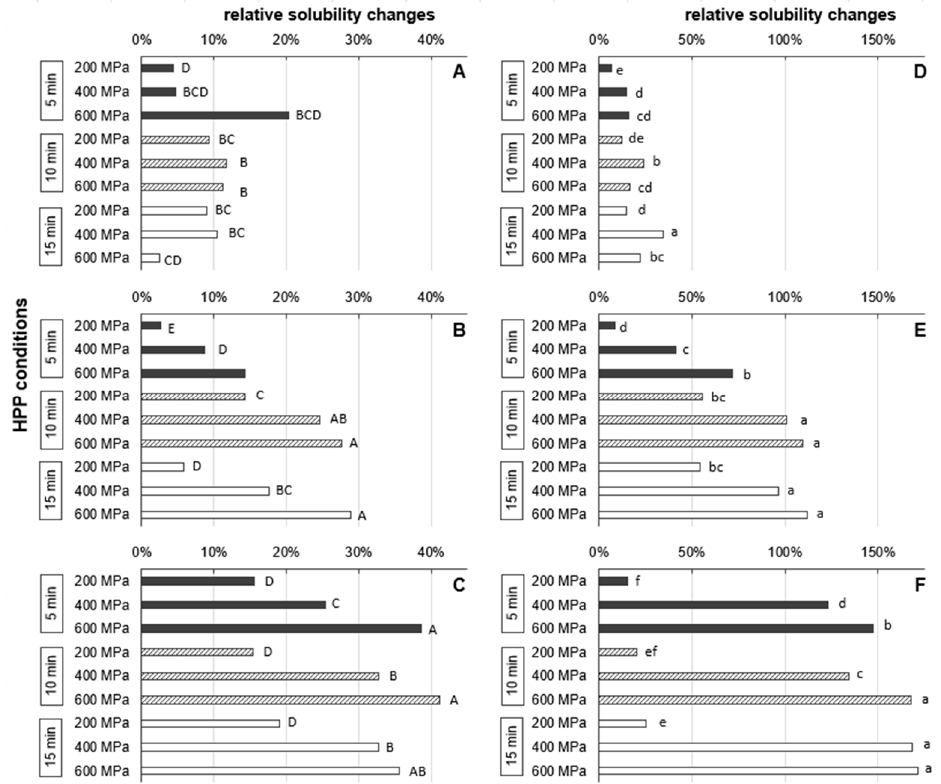
Figure 1. Relative variation of protein solubility (%) for the high-pressure processed samples, hav- ing as reference the solubility measured for non-pressurized samples. Results are shown for PPI (( A )—pH 6, ( B )—pH 7, ( C )—pH 8) and SPI (( D )—pH 6, ( E )—pH 7, ( F )—pH 8) samples. Different letters indicate significant differences ( p < 0.05) between samples represented in each figure.